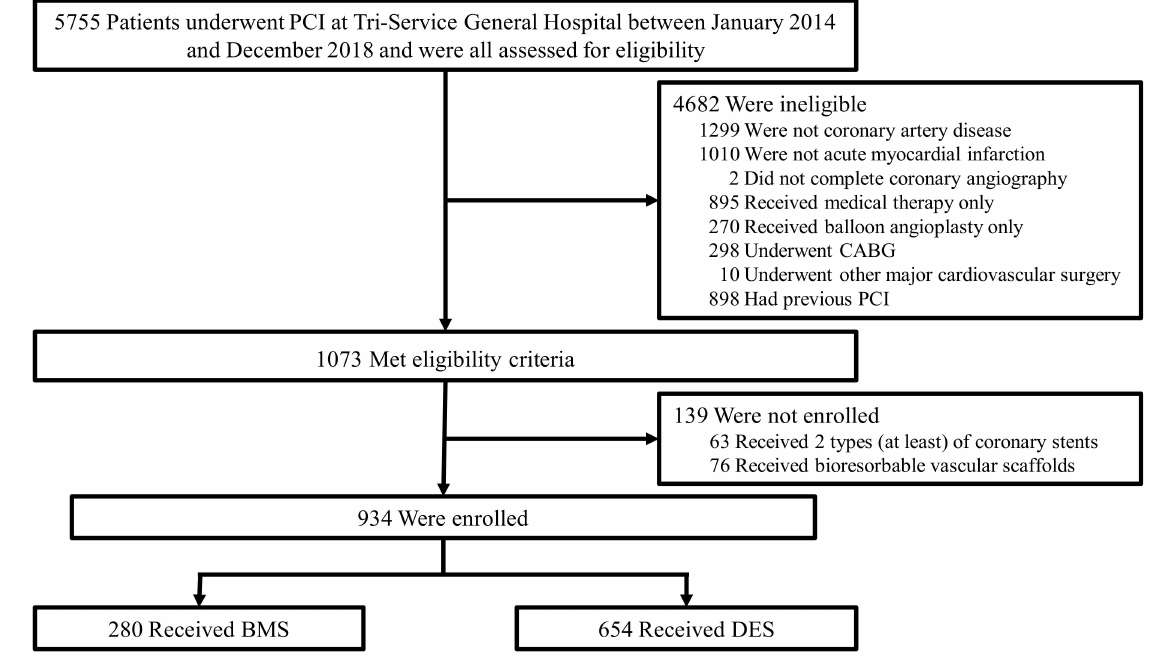
Figure 1. The flowchart for patient selection. BMS, bare-metal stent; CABG, coronary bypass graft surgery; DES, drug-eluting stent; PCI, percutaneous coronary